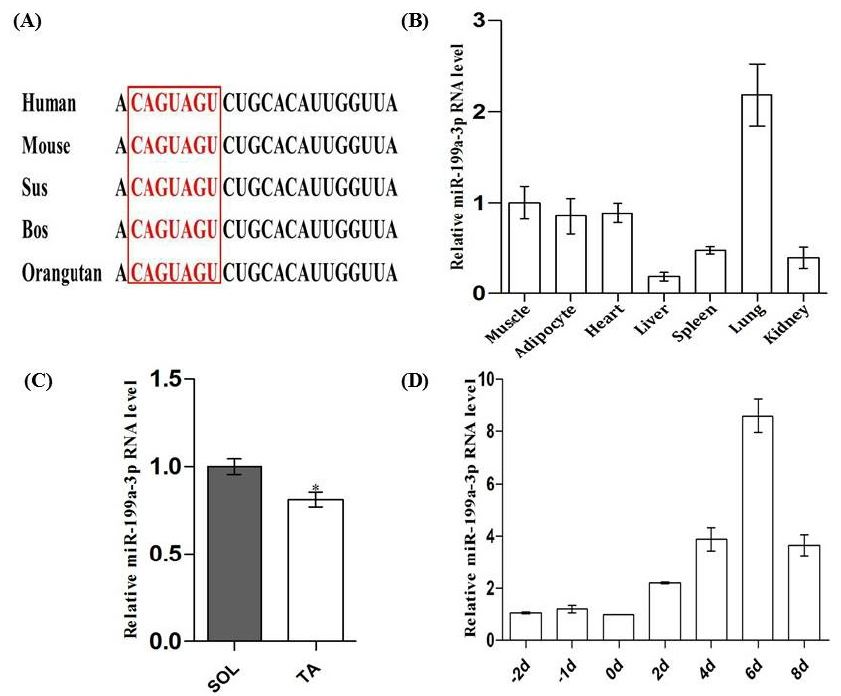
Figure 1. Tissue expression profile of miR-199a-3p and its expression pattern during C2C12 myogenic differentiation. ( A ) miR-199a-3p is conserved in mammals; ( B ) Tissue distribution of miR-199a-3p in adult mice; ( C ) Expression of miR-199a-3p in SOL (soleus: slow muscle) and TA (tibialis anterior: fast muscle) of adult mice; and ( D ) The expression of miR-199a-3p during C2C12 myoblast differentiation. Results are presented as mean ± S.E.M. n = 3. * p <